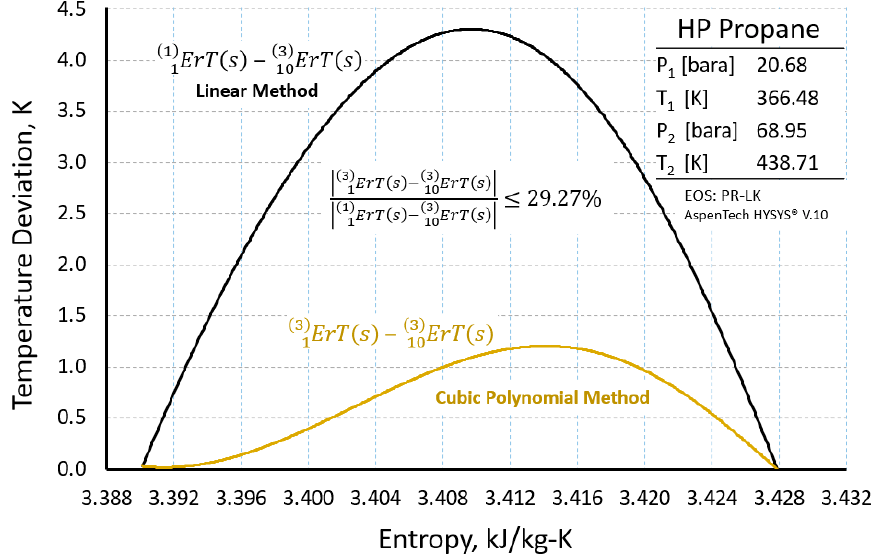
Figure 5. Distribution of temperature deviation shows the maximum error of cubic polynomial endpoint approximant is less than one third of the linear endpoint approximation.